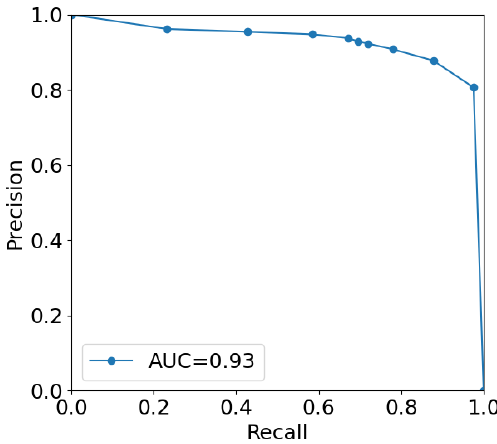
Figure 10. Precision-Recall curve for the